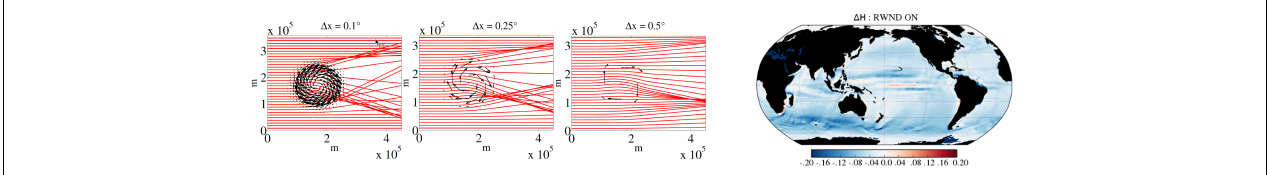
FIGURE 3 | (Left panels) Wave ray refraction on a theoretical eddy. Three different spatial resolutions of the eddy are shown (from left to right): 0.1 ◦ , 0.25 ◦ , and 0.5 ◦ . (Right panel) Difference between H s fields for the simulations with and without currents, if the option of the relative wind speed with respect to the current is activated [Figure is reproduced from Rapizo et al.